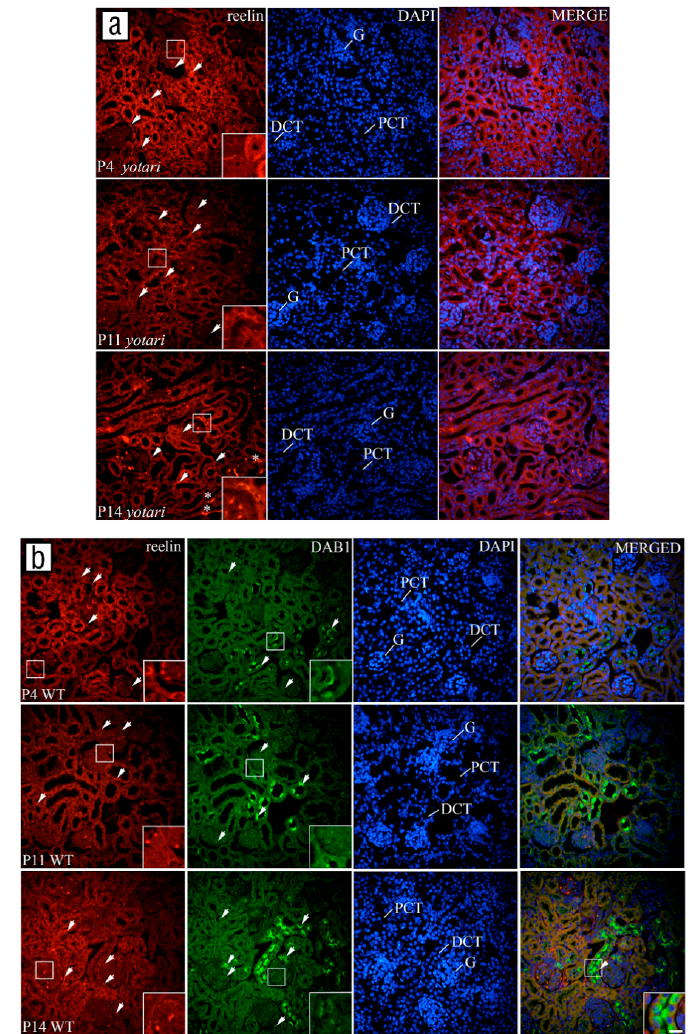
Figure 4. Immunofluorescence staining of postnatal yotari kidneys with reelin marker ( a ) and double immunofluorescence staining of postnatal wild-type kidneys with DAB1 and reelin markers ( b ). ( a , b ) Nuclear DNA DAPI staining merged with DAB1, and reelin immunofluorescence is shown in parallel (merge). Observed time points were P4, P11, P14. Expression of the examined markers in the glomeruli (G), proximal convoluted tubules (PCT) and distal convoluted tubules (DCT) is marked with the arrows, while asterisks are indicating expression of the reelin in the ex- tracellular matrix ( a ). Inserts show the most prominent expression in the image. DAPI nuclear staining revealed poor colocalization of DAB1 and reelin, mostly in the DCT (arrowhead). Scale bar is 20 µm and refers to all images.